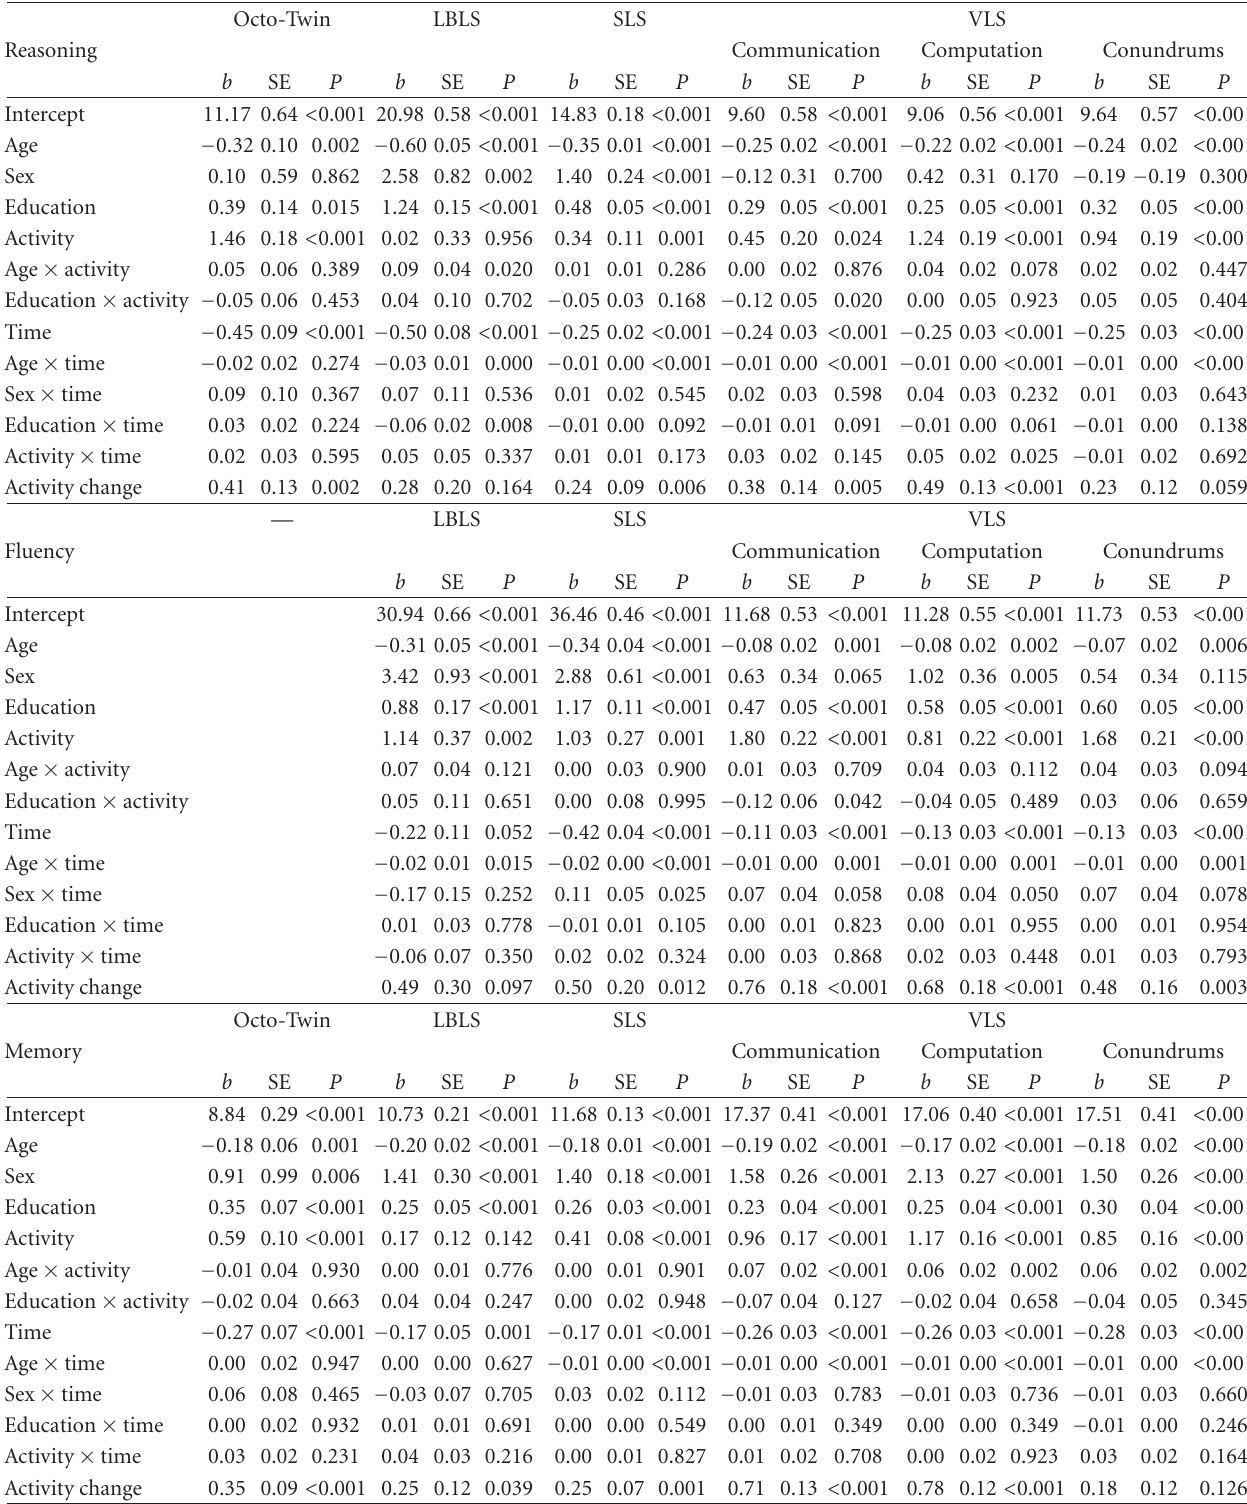
Table 5: Mixed e ff ects model summaries across four studies with baseline cognitive activity and activity change predicting four cognitive